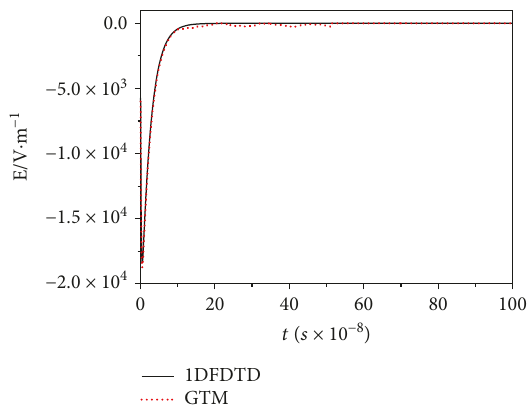
Figure 7: The re fl ected wave of FDTD and Fourier transform method.